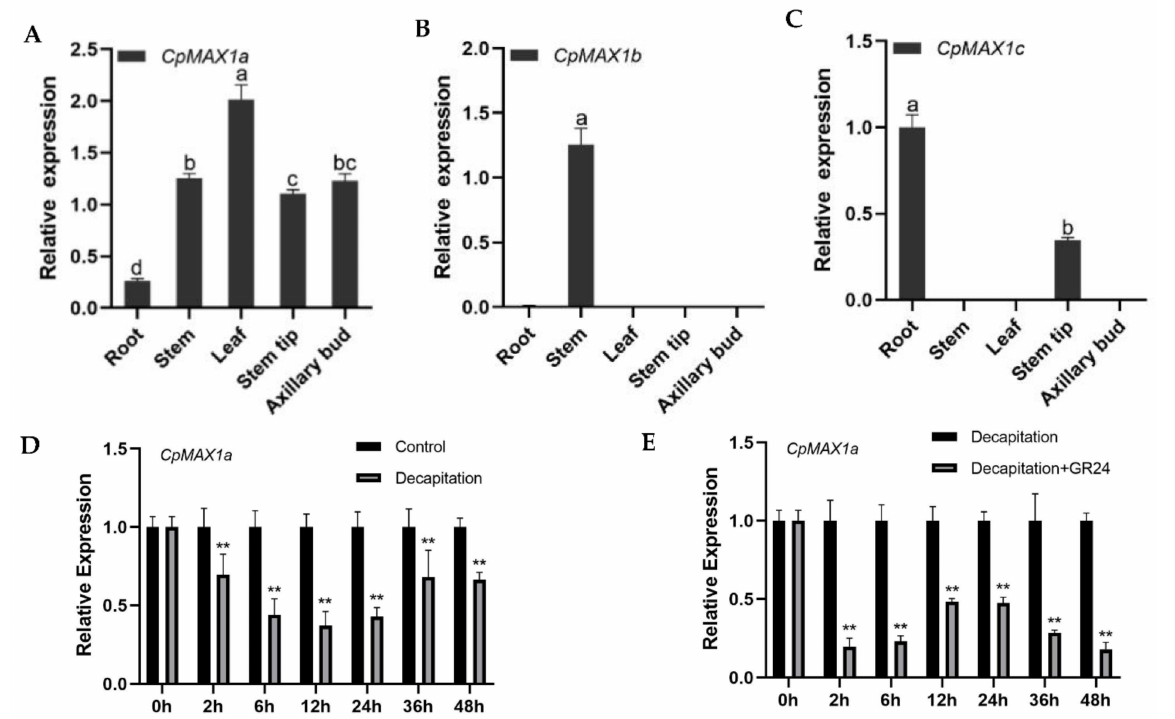
Figure 2. Expression analysis of CpMAX1 in wintersweet. Expression levels in different tissues of ( A ) CpMAX1a , ( B ) CpMAX1b , and ( C ) CpMAX1c genes. ( D ) Expression levels of CpMAX1a in axillary buds after decapitation. ( E ) Expression of CpMAX1a in axillary buds after decapitation and the decapitation + GR24 treatment. Data shown are the mean ± standard deviation (SD) of three technical replicates. Different lowercase letters (a–d) above bars indicate significant differences (** p < 0.01).